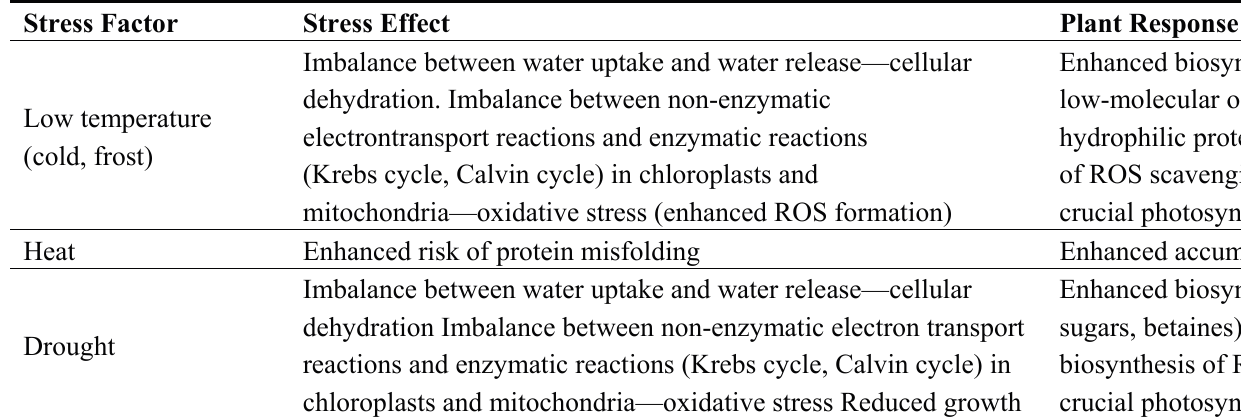
Table 1. Basic characteristics of the major effects of abiotic stresses on plant biological mechanisms including plant stress response. Abbreviations: COR—cold-regulated (protein); GDC—glycine decarboxylase; HSP—heat shock (protein); LEA—late embryogenesis-abundant (protein); MDH—malate dehydrogenase; NADP-ME—NADP malic enzyme; PCD—programmed cell death; ROS—reactive oxygen